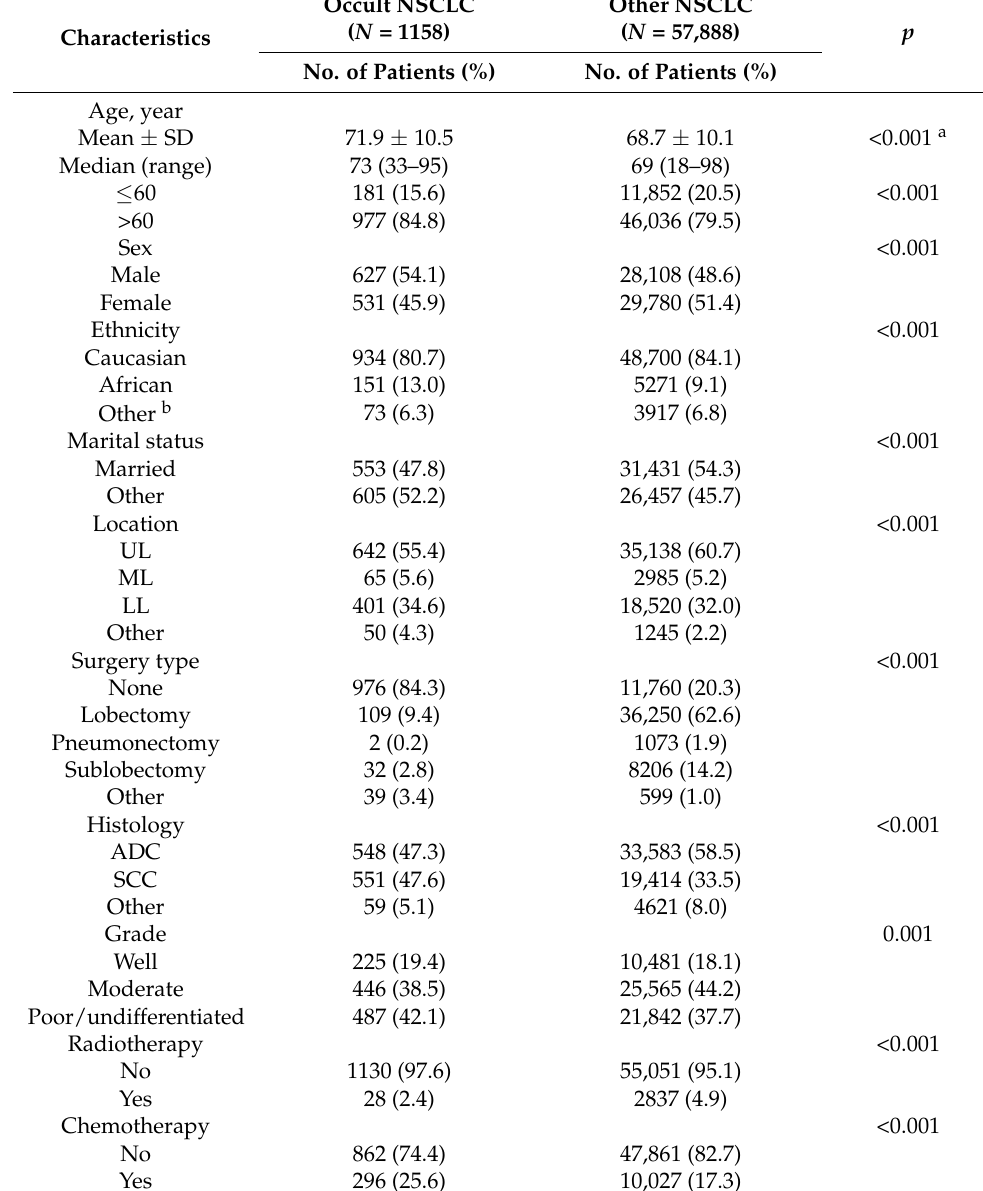
Table 1. The clinicopathological features of included